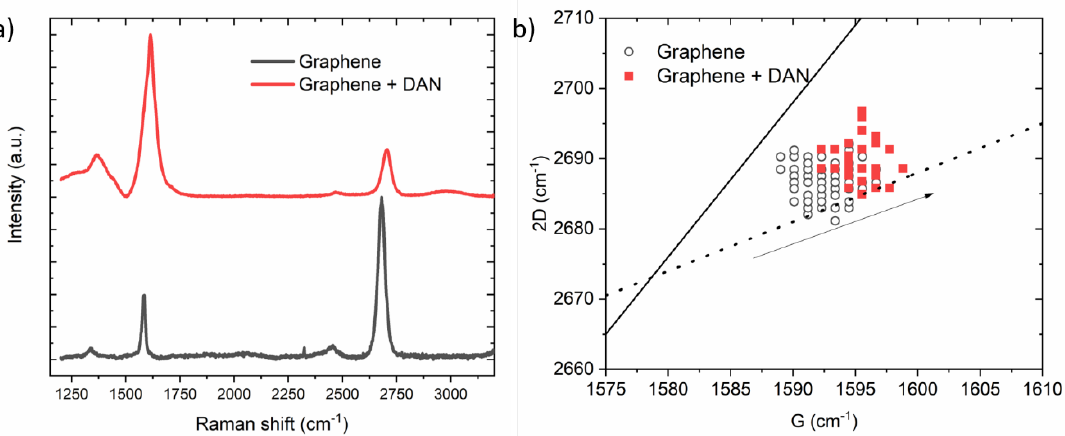
Figure 2. ( a ) Raman spectra for an unmodified graphene device (black curve) and a graphene device functionalized with DAN (red curve); ( b ) Scatter plot marking G and 2D positions from an unmodified graphene device (white circles), and after modification with DAN (red squares).